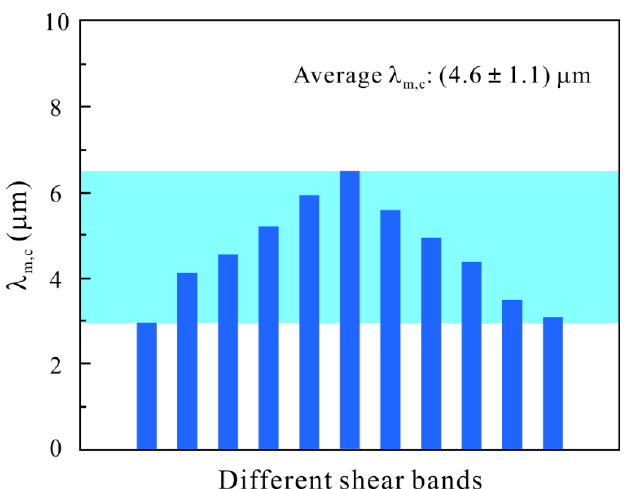
Figure 9. Critical shear offset for crack initiation, λ m,c , in different shear bands after cyclic compres- sion [48].